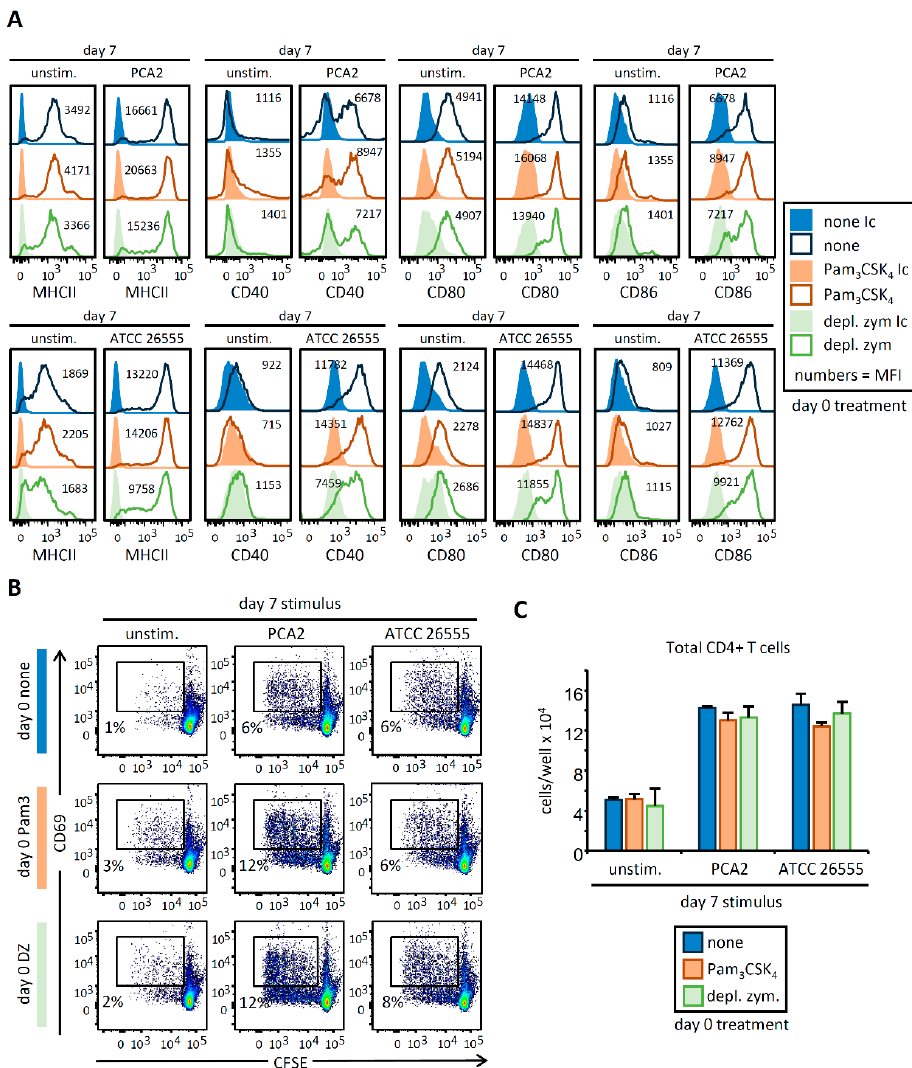
Figure A2. ( A ) Histograms and MFIs (numbers) corresponding to data shown in Figure 3A colormaps. ( B ) Percentage of proliferating CD4 + T cells expressing CD69 from cocultures obtained as indicated in Figure 4A. ( C ) Total CD4 + T cell numbers in the cocultures obtained as in Figure 4B, data represent means ± SD of triplicate cultures. Results shown are from one experiment representing three independent experiments.